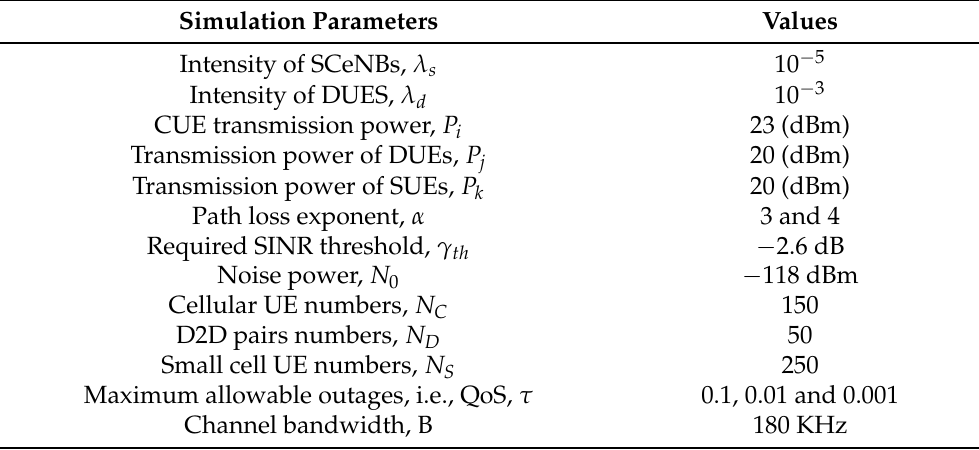
Table 2. Parameters used in the